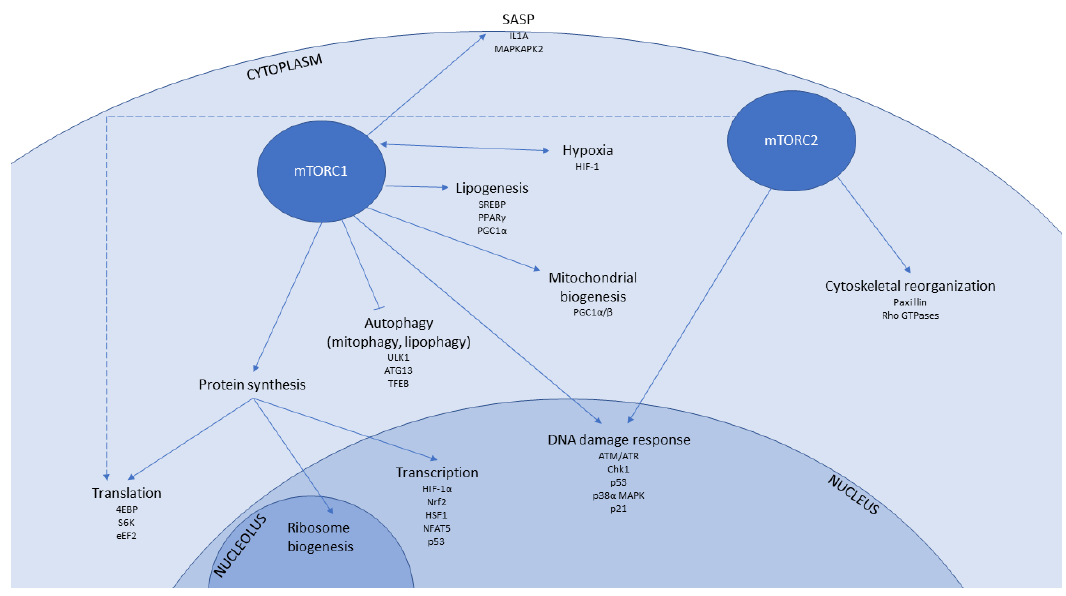
Figure 1. Summary of pathways targeted by mTOR signalling which are implicated in modulation of senescence and ageing. Arrows indicate that mTORC activity positively regulates the process, while bars indicate inhibition.